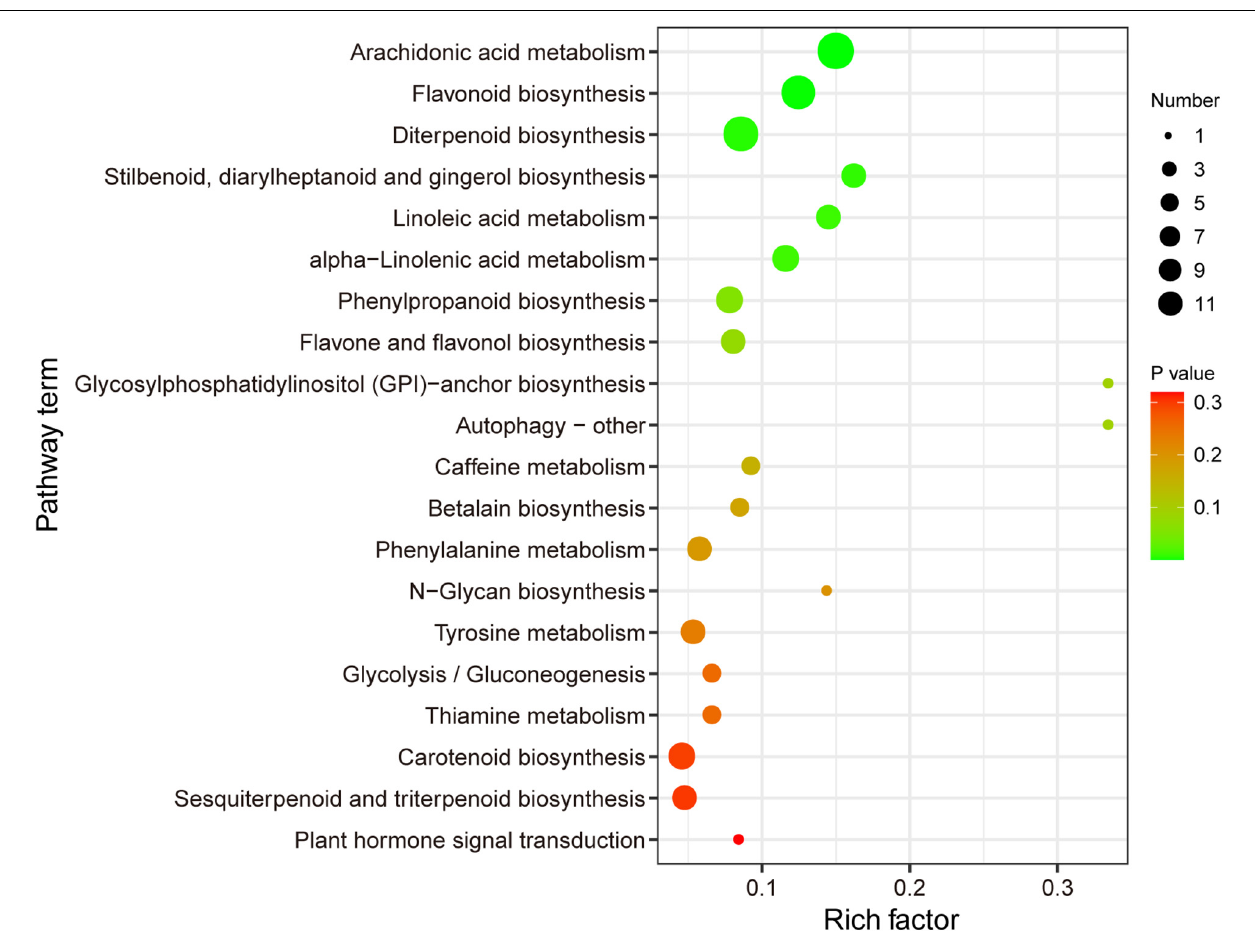
FIGURE 2 | Kyoto Encyclopedia of Genes and Genomes analysis of differentially synthesized metabolites (DSMs). The x - and y -axes represent the enrichment factor and the pathway term, respectively. The colors and sizes of the dots represent the significance ( p ) and the number of metabolites, respectively.